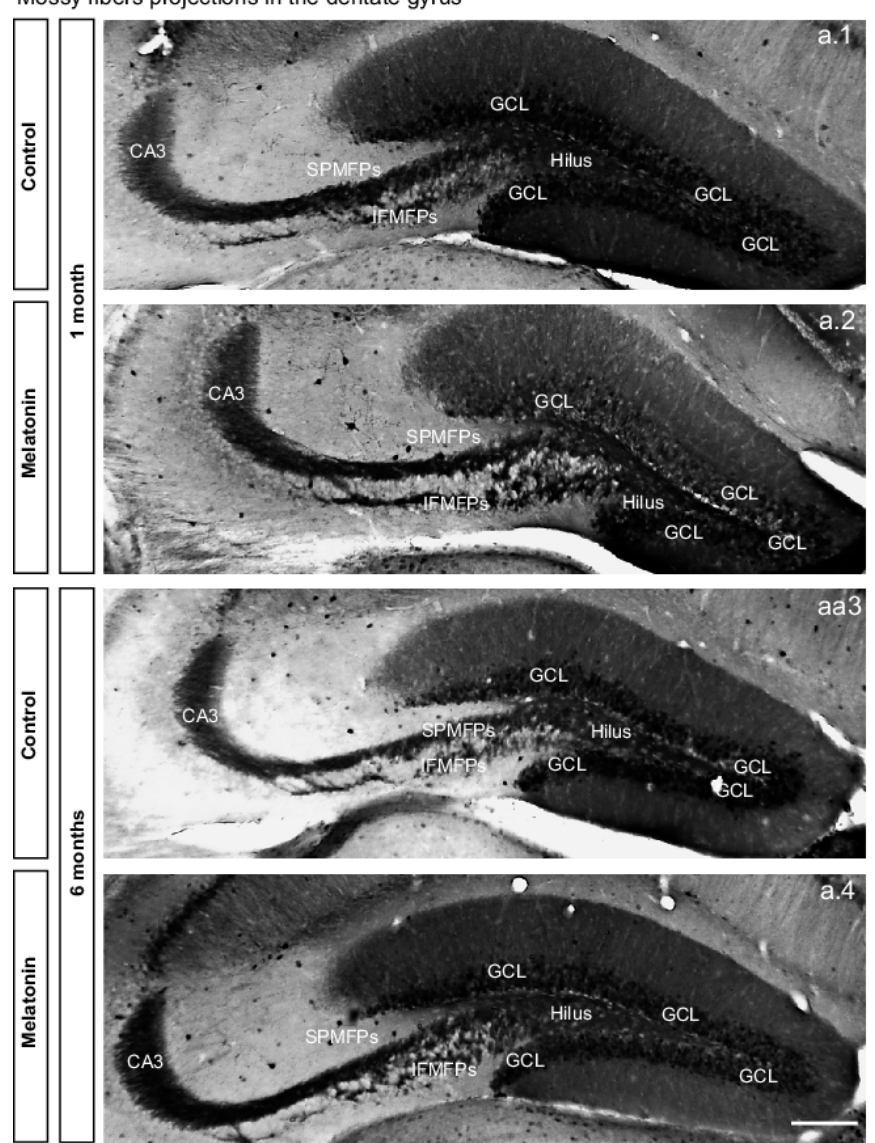
Figure 4. Expression of calbindin in the dentate gyrus after treatment with melatonin for one- or six-months in male Balb/C mice. ( a.1 – a.4 ) Representative images of coronal sections of mice treated with vehicle or melatonin (8 mg/kg, body weight; b.w;) sections are shown. Images of melatonin-treated mice show increased labeling of calbindin than that found in vehicle treated mice. Scale bar = 150 µm. The bright field also shows the granule cell layer (GCL), hilus (H), molecular layer (ML), suprapyramidal (SPMFPs) and infrapyramidal-mossy fiber projections (IPMFPs), and the Cornu Ammonis 3 (CA3) regions, respectively.